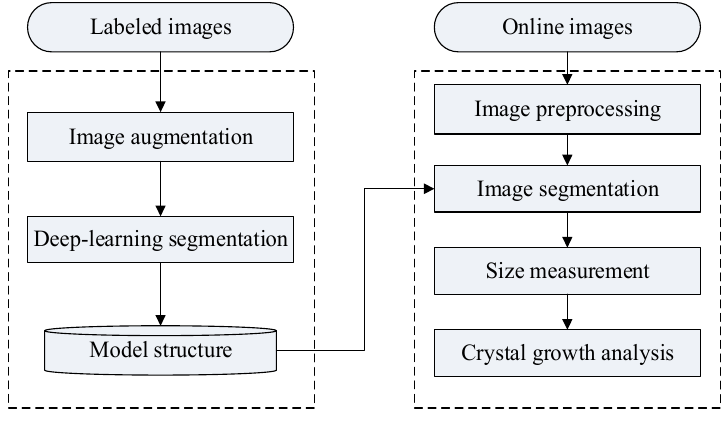
Figure 3. Flow chart of the proposed image measurement.